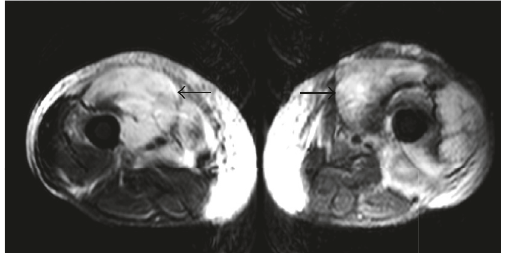
Figure 4: MRI of the thighs, coronal section, showing hyperintense signals on T2 weighted images bilaterally (black